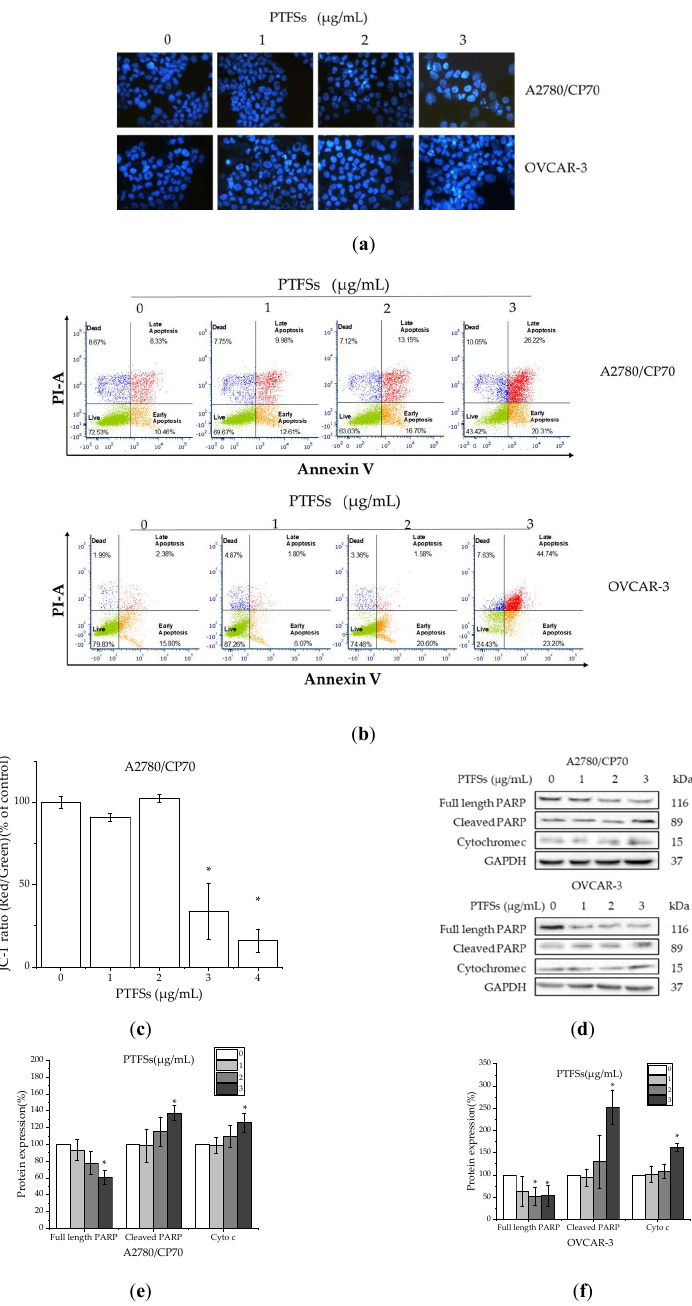
Figure 3. PTFSs induced apoptosis in A2780 / CP70 and OVCAR-3 cells. ( a ) Cells stained with Hoechst 33342 were detected by fluorescent microscopy (magnification, × 400), after being treated with various concentrations of PTFSs for 24 h. The bright nuclei represent apoptotic cells. Intact nuclei represent viable cells. ( b ) Cells treated with various concentration PTFSs were detected by flow cytometry using a double-staining method with FITC-conjugated Annexin V and PI. ( c ) Quantification histograms represent the ratio of JC-1 aggregates to JC-1 monomers (ratio of 590:530 nm emission intensity) of A2780 / CP70 cells, which reveals ∆Ψ m dissipation after 24 h treatment with various concentrations PTFSs. ( d – f ) Protein levels of full length PARP, cleaved PARP, and cytochrome c were detected by Western blotting. GAPDH was utilized for an endogenous reference to standardize protein levels. All data were expressed as mean ± SEM of three independent experiments. * p < 0.05 compared with the control group. Above four treatments concentration of PTFSs were 0, 1, 2, and 3 µ g / mL